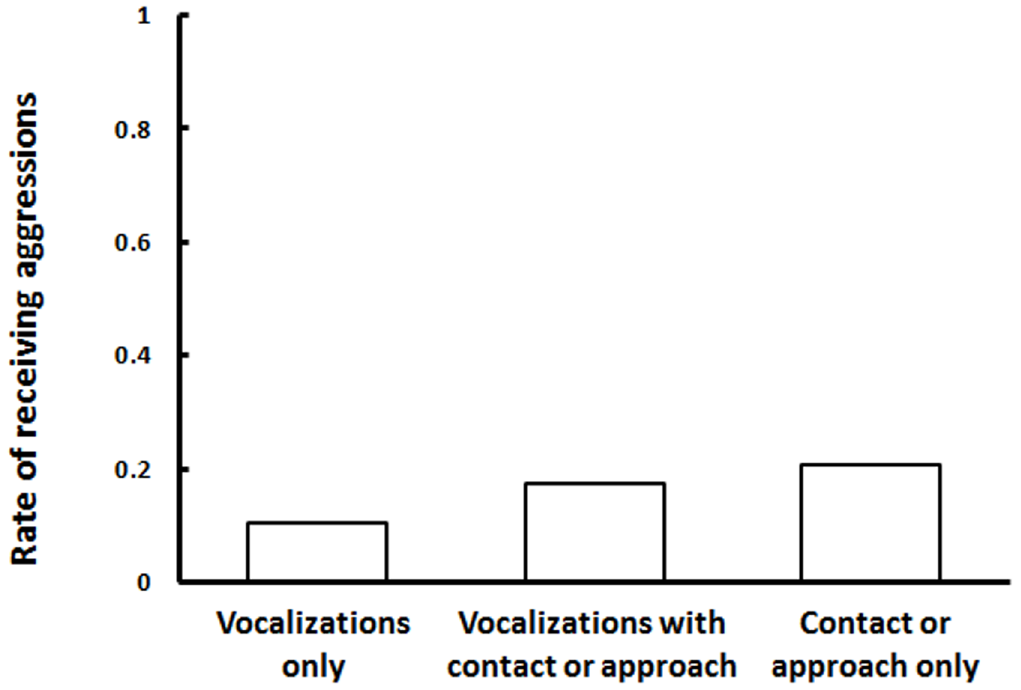
Fig 3. Differencesbetween the proportion of post-conflict (PC) sessions during which victims received aggression after victims used vocalizations only ( n = 19), vocalizations with contact or approach ( n = 29), and contact or approach only ( n =